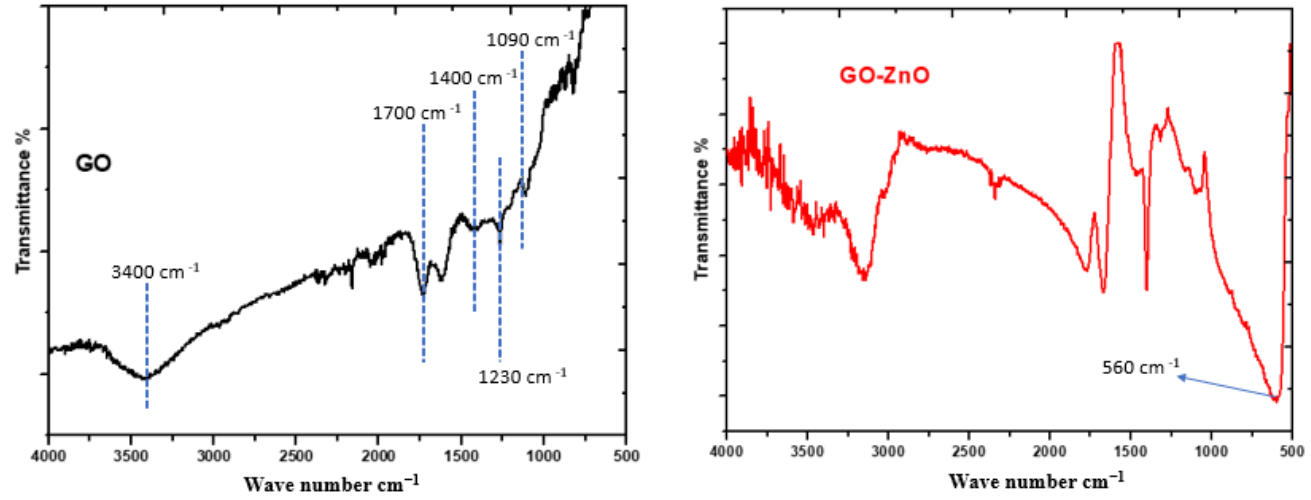
Figure 1. FTIR spectra of the synthesized material.